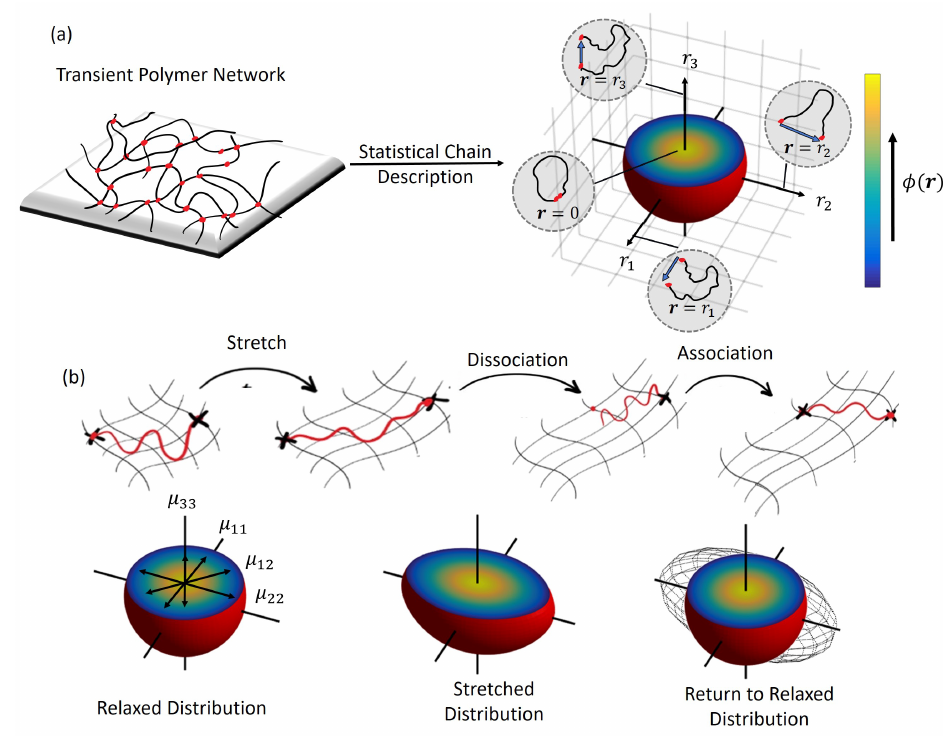
Figure 1. Statistical description of a transient polymer network with ( a ) the end-to-end vector, r and the chain distribution function, φ ( r ) illustrated with 3D mapping, and ( b ) evolution of the chain distribution function, φ ( r ) and tensor µ shown w.r.t the chain stretch λ